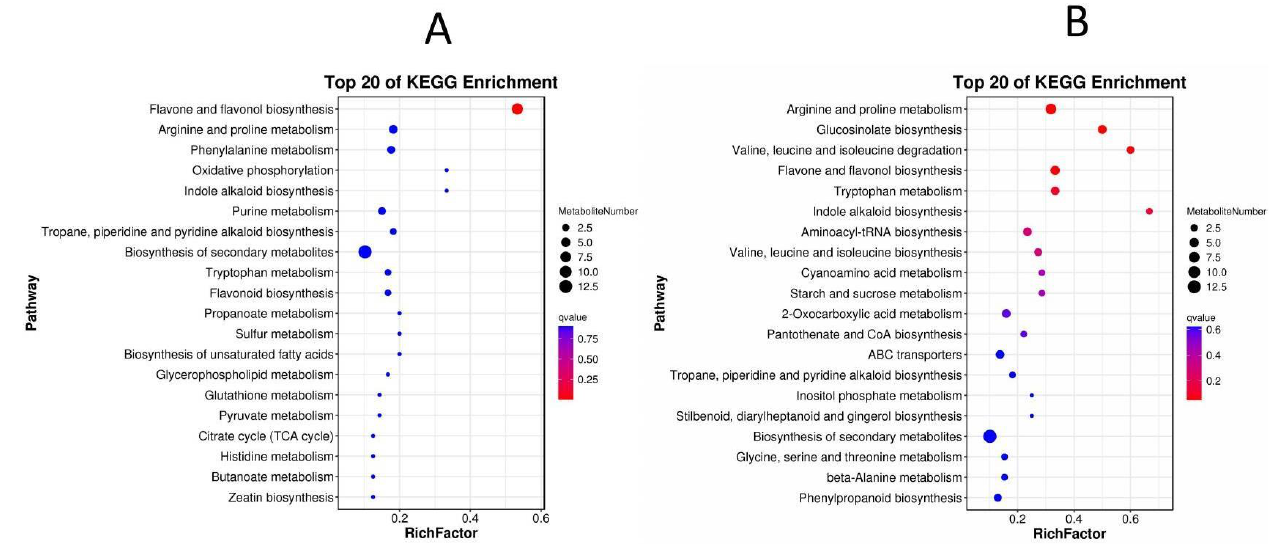
Figure 9. Pathway Mapping and Enrichment that Resulted from Differentially Accumulated Metabolites (DAMs) Analyzed in KEGG. ( A ) The top 20 metabolisms that resulted from 99 DAMs were enriched via KEGG analysis to show the differentiation between the treated (C-Y) and control (CK-Y) leaves. ( B ) The top 20 metabolisms that resulted from 88 DAMs were enriched via a KEGG analysis to show the differentiation between the treated (C-J) and control (CK-J) stems. The ordinate shows the metabolisms. The abscissa shows the enrichment factor, which is the number of differential metabolites divided by all the numbers in the pathway. The bubble sizes indicate the number of metabolites. The trend of colors from blue to read indicates the Q values. KEGG, Kyoto Encyclopedia of Genes and Genomes.